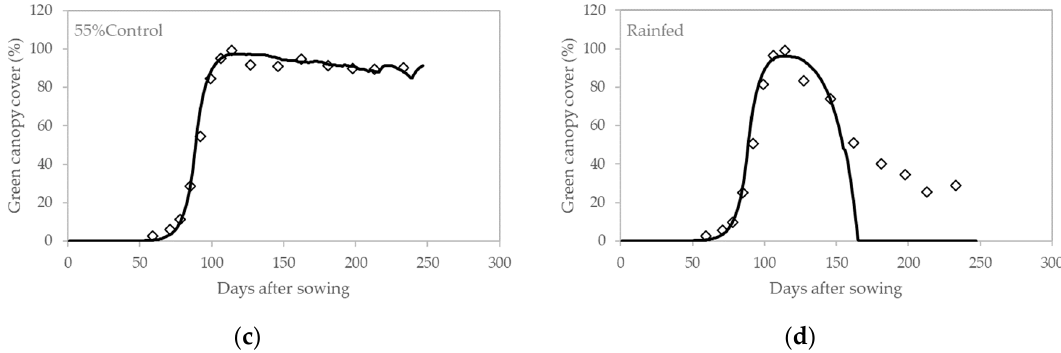
Figure 1. Observed and simulated seasonal course of green canopy cover for the irrigation treatments of the AIMCRA experiment used for model calibration: ( a ) control, ( b ) 70% control, ( c ) 55% control, and ( d ) rainfed. Table 2. Calibrated values for selected AquaCrop crop parameters for sugar beet. The AquaCrop default values for sugar beet and the values calibrated in selected previous studies are shown. Information about the calibration process (model version, location, observed yield range, and evaluated variables) is presented. CC, B, and Y are green canopy cover, biomass, and yield, respectively.